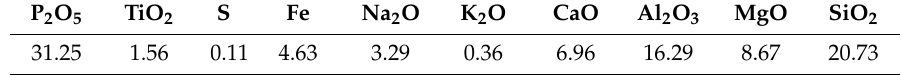
Table 6. Main chemical composition analysis of phosphorous concentrate (%).